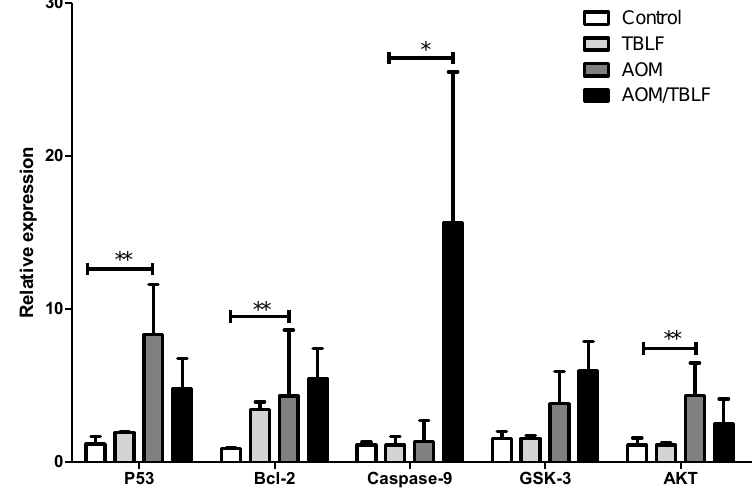
Figure 9. Evaluation of the gene expression of TP53, Bcl-2, caspase 9, GSK-3, and AKT in rat colon tissues administered with AOM/DSS and treated with TBLF. Rats were intraperitoneally administered for two weeks with AOM and a further two weeks with DSS in their daily drinking water to develop ACF. Next, they were administered with TBLF (50 mg/kg) on alternate days for six weeks via intra-gastric cannula. The results are shown as a relative expression to the constitutive gene HPRT and as a proportion of the control ± SD. (*) indicates significant difference p ≤ 0.05 and (**) indicates significant difference p ≤ 0.01 by one-way ANOVA with Dunnett post hoc.